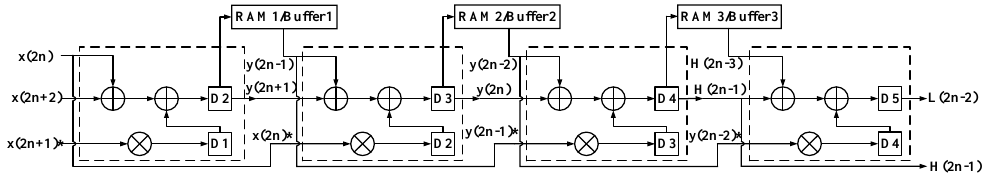
Figure 4. The 1-D discrete wavelet transform (DWT) structure for the first level. Note: The items with * are the multiplication terms that should arrive ahead of time.